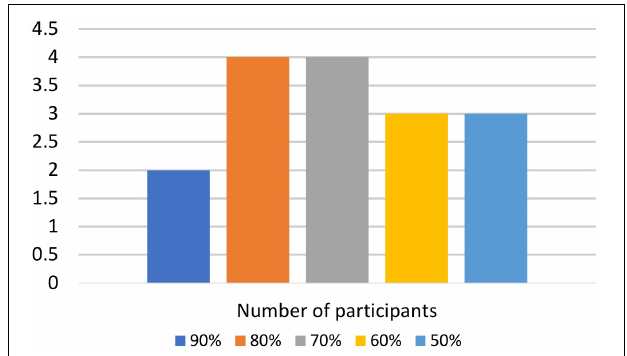
FIGURE 6 | Chinese–Japanese bilinguals’ L2 proficiency level. The limited number of highly proficient bilinguals may be why the L2 proficiency level did not show a consistent effect on the accuracy rate and brain activation